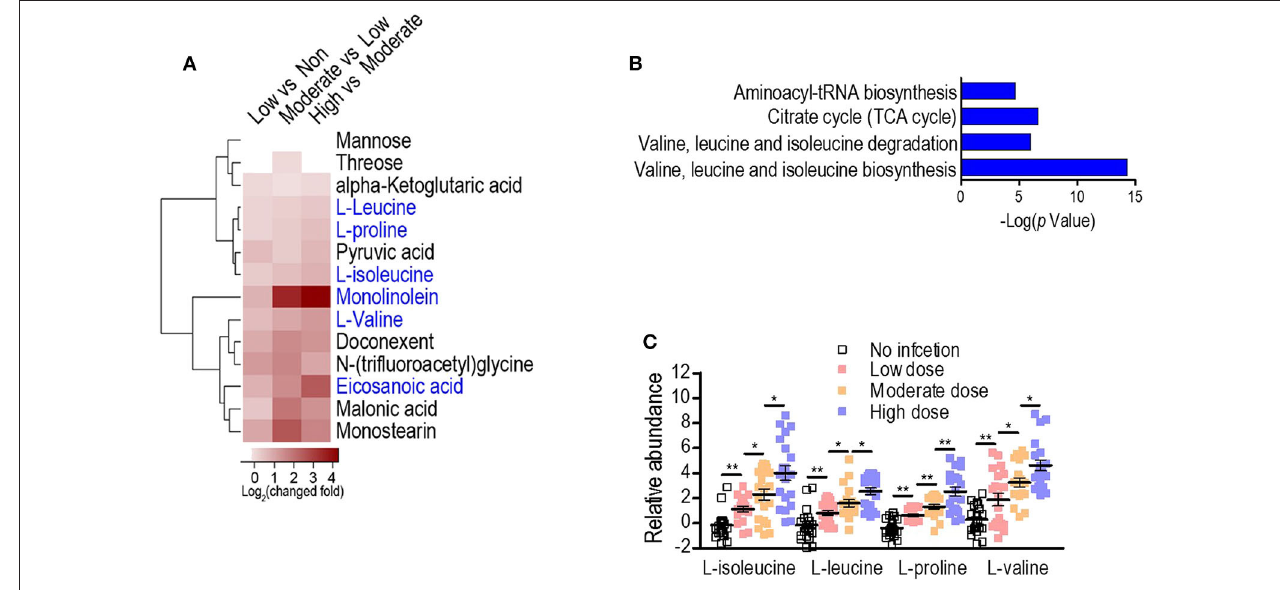
FIGURE 2 | Serum metabolome analysis reveals L-isoleucine, L-leucine, L-proline, and L-valine as potential anti-infection metabolites against S. aureus infection. (A) Heat map representation of unsupervised hierarchical clustering of significant metabolites. (B) Pathway enrichment analysis of the differential metabolites. A horizontal histogram shows the impact of the enriched pathway with P < 0.01. (C) The abundance of L-isoleucine, L-leucine, L-proline, and L-valine in no infection, Low, Moderate, and High dose groups. Error bars ± SEM ( n = 10, technical replicate = 2), * P < 0.05 and ** P < 0.01 (one-way ANOVA).